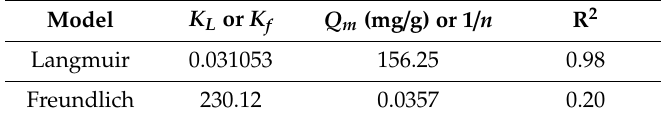
Table 1. Adsorption parameters for the Langmuir and Freundlich adsorption models.